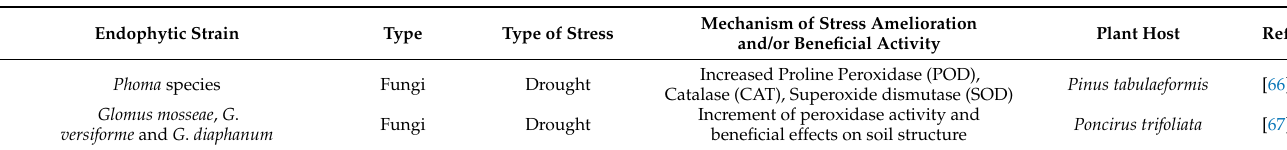
Table 1. Examples of studies reporting beneficial activities between microbial endophytes and their plant host under drought and salinity stress